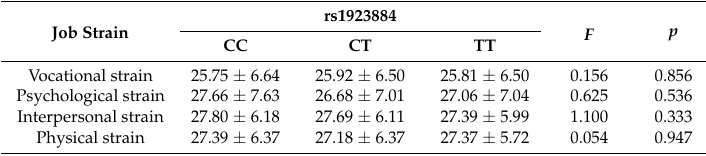
Table 7. Association between rs1923884 polymorphism and job strain subscales.